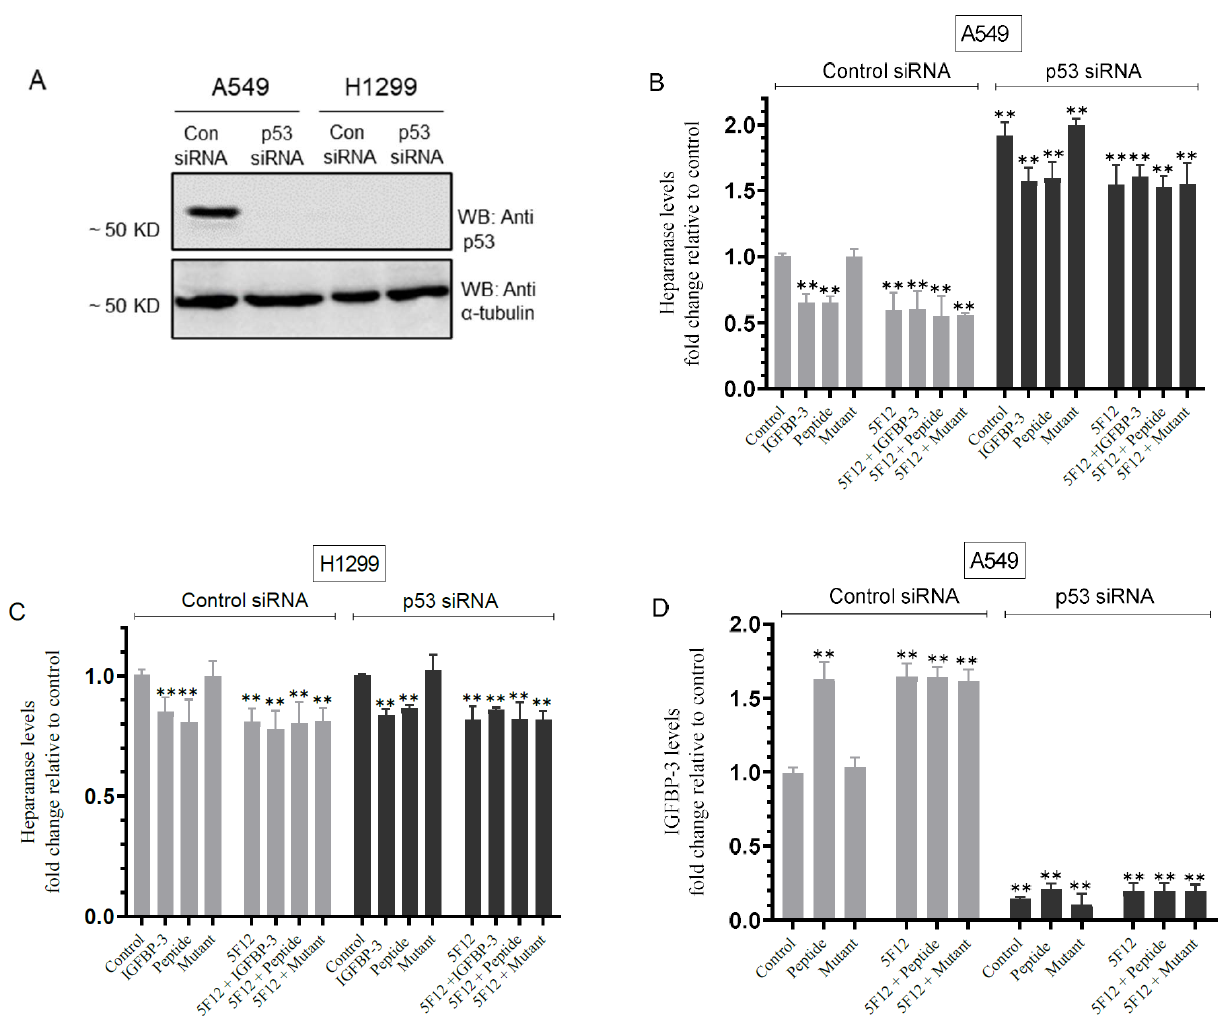
Figure 6. Knockdown of p53 led to increased heparanase levels and decreased IGFBP-3 levels in the media of A549 cells. Cells (0.2 × 10 5 ) were grown in 10% FBS-supplemented media for 24h then serum-starved overnight. The cells were then treated as indicated for 72h with control siRNA or p53 siRNA. The same concentration of total protein (15 µL of 600 µg/mL) of the cell lysates ( A ) was used for Western blotting using the indicated antibodies. As a loading control, anti α -tubulin antibodies were used. Transfected cells were treated with 50 nM of IGFBP-3 protein/peptide/mutant, the CD44 antibody (5F12, 5 µg/mL) added either separately or 2h prior to addition of IGFBP-3/peptide/mutant, or in combination ( B – D ). The levels of heparanase ( B , C ) and IGFBP-3 ( D ) were measured in the media using the same amount of protein (3 µL of 600 µg/mL total protein) as described in the Materials and Methods section. The graphs summarize the results expressed as means ± SD ( n = 5) using the GraphPad 9.4.1 software. Fold change was calculated relative to the A549 control siRNA ( B , D ) or H1299 control siRNA ( C ). Asterisks indicate a statistically significant difference from the corresponding negative control of each cell line, Mann–Whitney test. Statistical differences between different groups were analyzed by a non-parametric Kruskal–Wallis test. Absence of asterisks indicates no significance, ** p < 0.0l.